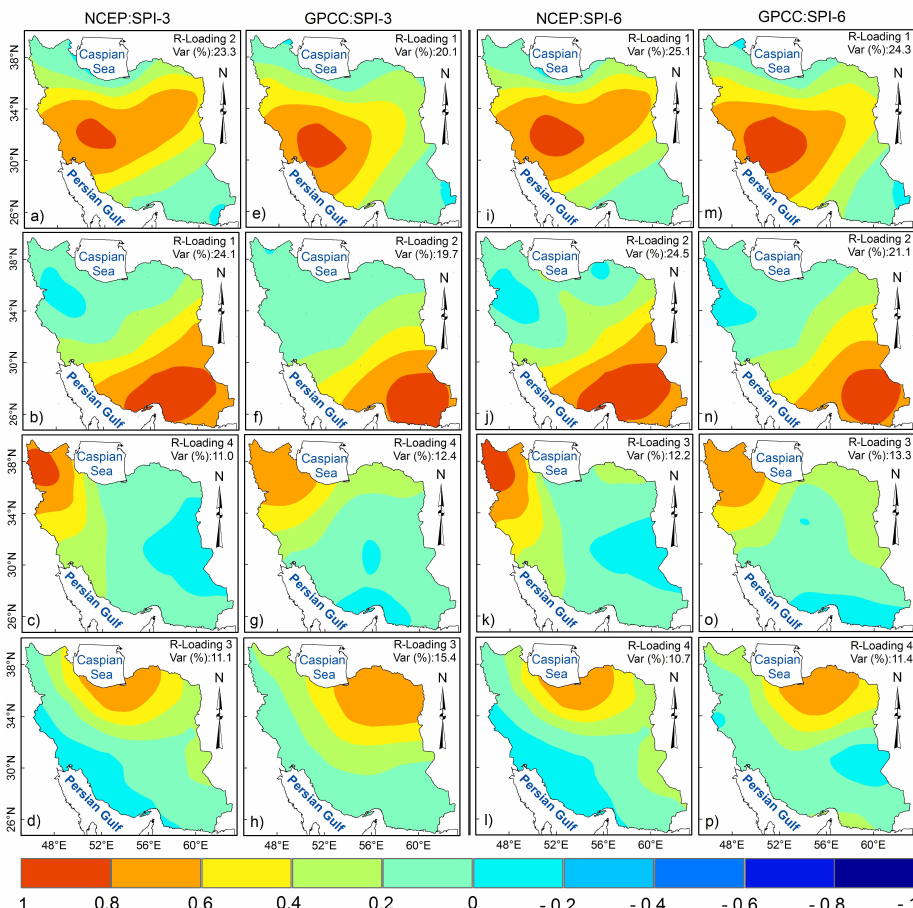
Fig. 7. The four Varimax rotated loadings for NCEP/NCAR and GPCC datasets of the SPI field on: (a–h) 3-month time scale, (i–p) 6-month time scale. Percentages of variances explained by the rotated loadings are displayed on the upper right